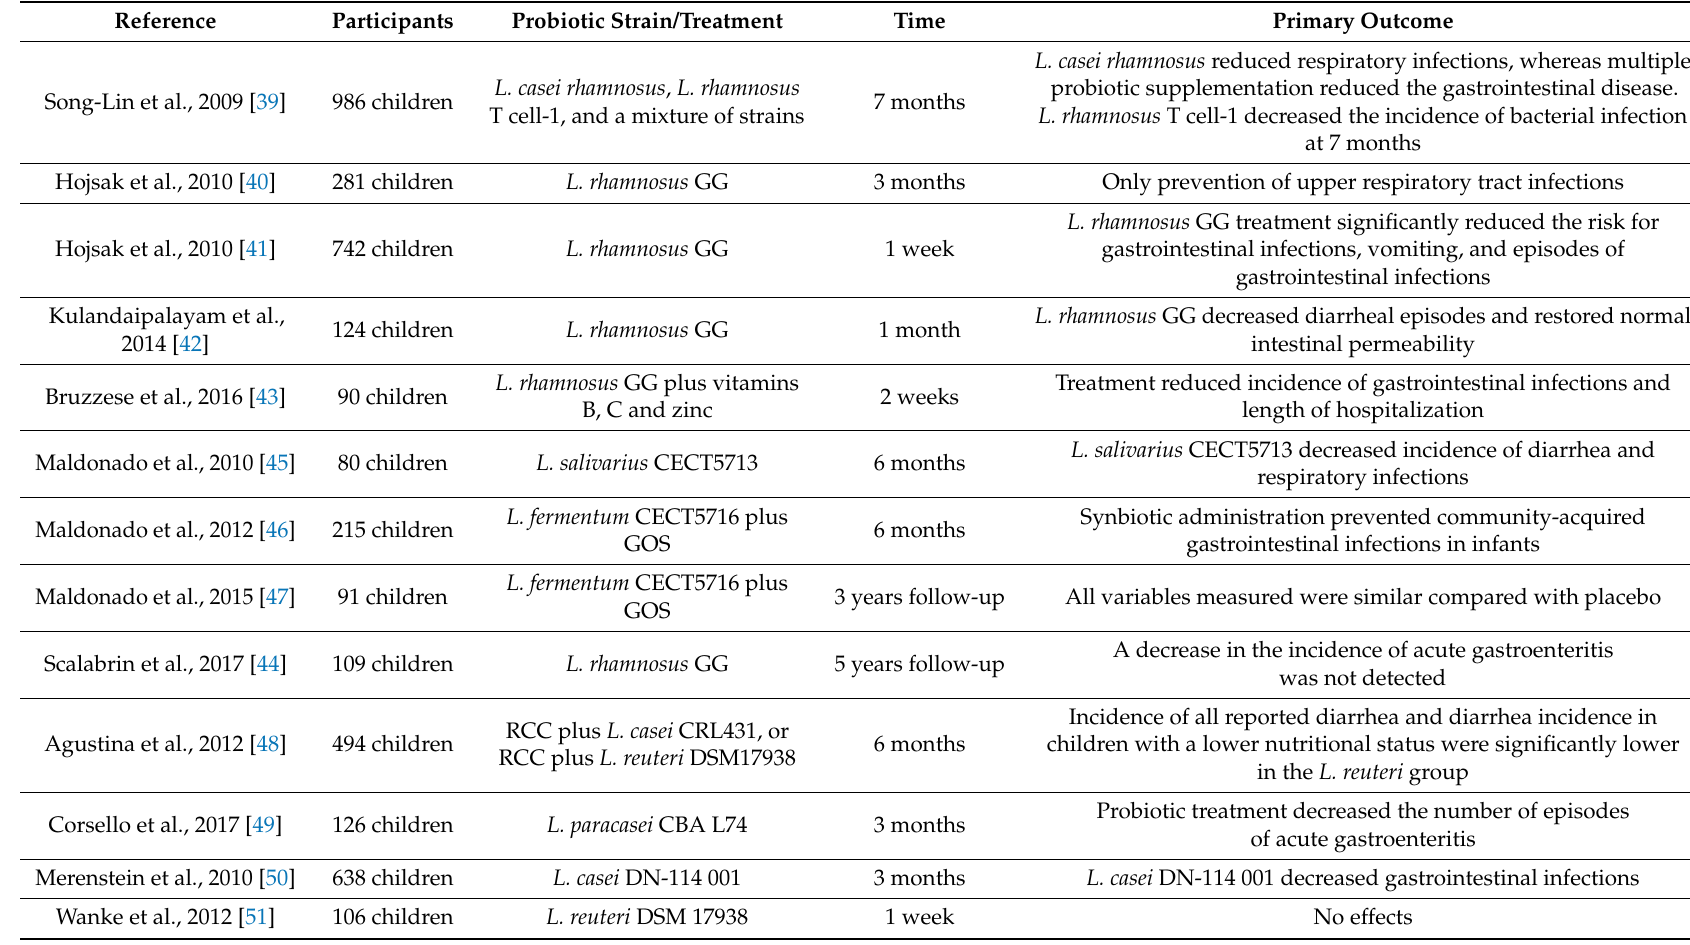
Table 1. Prevention and treatment of pediatric gastrointestinal infections with